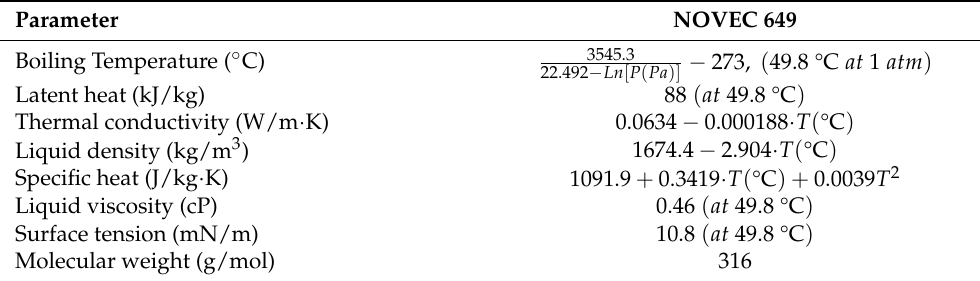
Table 1. NOVEC 649 properties